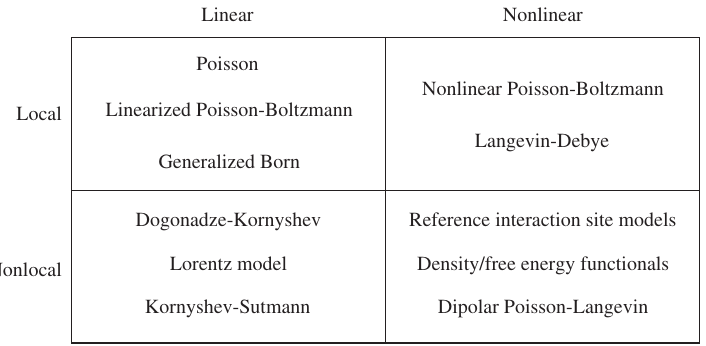
Figure 2 Simple models for protein-solvent electrostatics can be categorized roughly into four categories, depending on whether they are linear or nonlinear, and local or